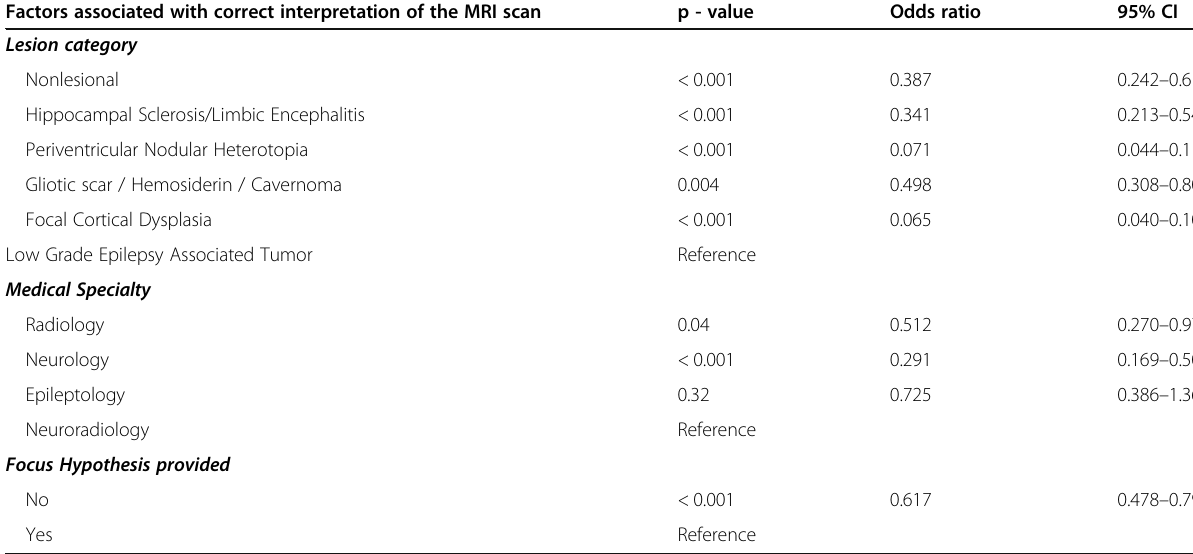
Table 4 Multivariable binary logistic regression analysis based on general linear mixed - effects model, entire dataset Factors associated with correct interpretation of the MRI